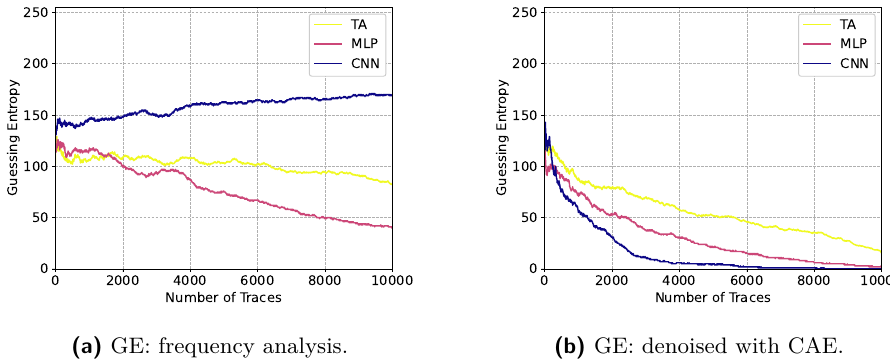
Figure 8: Guessing entropy: denoising clock jitters with frequency analysis vs